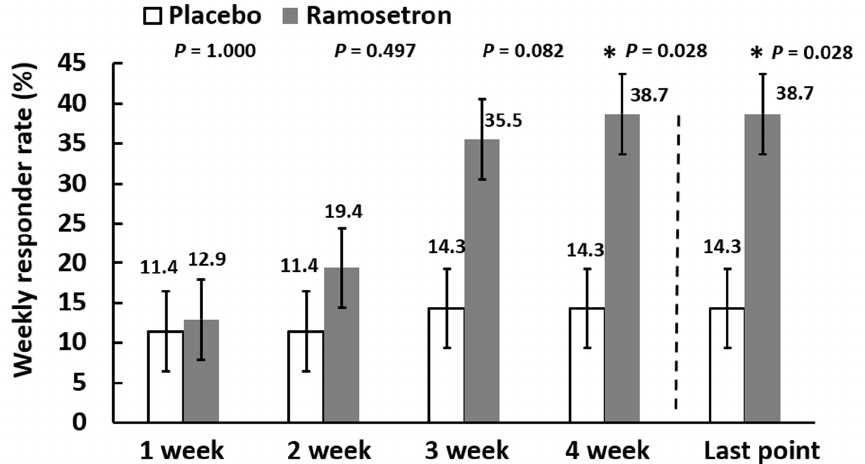
Figure 5. Weekly responder rates for improvement of bowel habits. Results are expressed as mean ± SD. * p < 0.05 vs. placebo.